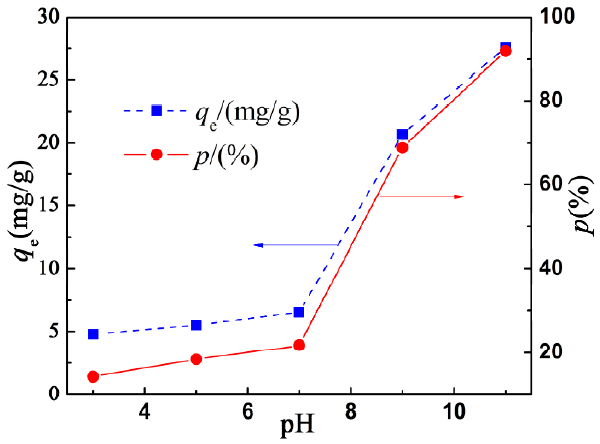
Figure 2. Effect of the pH on MV adsorption on α‐ Fe 2 O 3 @PHCMs.